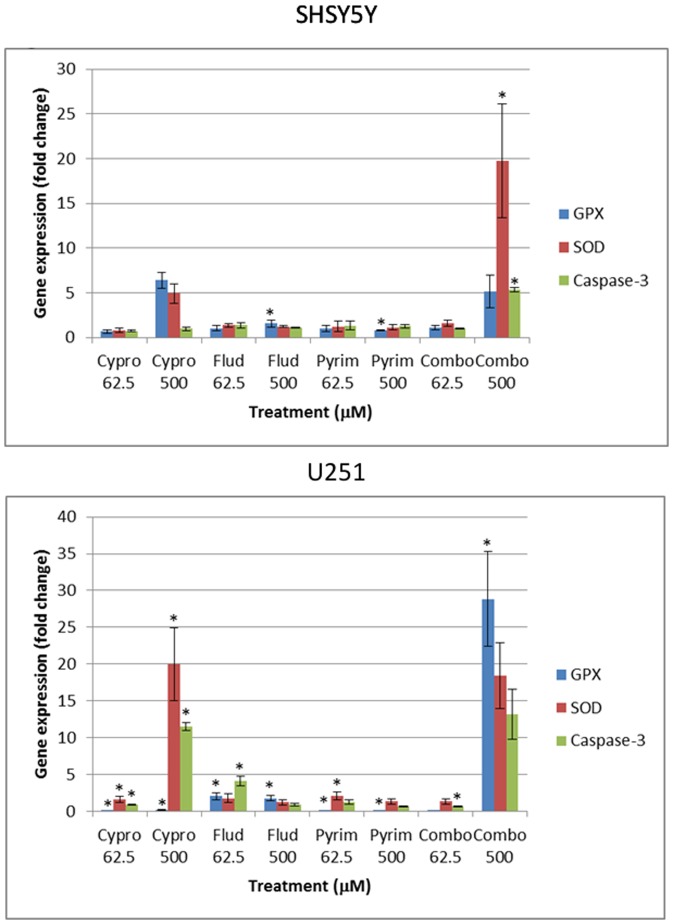
Fold changes in the expression of GSH peroxidase, superoxide dismutase and caspase-3 after the incubation of SH-SY5Y and U251 cells with pyrimethanil, cyprodinil and fludioxonil singly and in a mixture at a low (62.5 µM) and high (500 µM) exposure concentration over 48 h (n = 3 per determination; *, P<0.05).